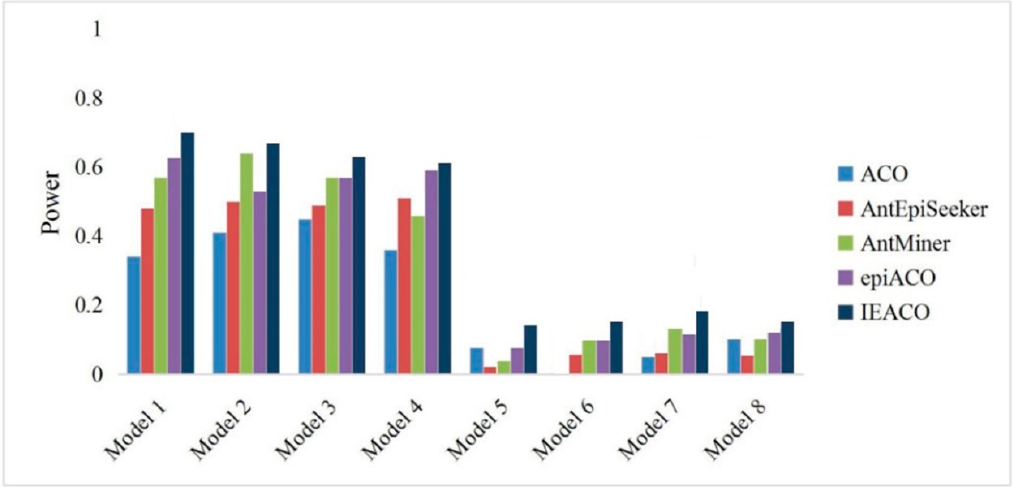
Figure 4. Power comparison on 5000-SNP datasets.